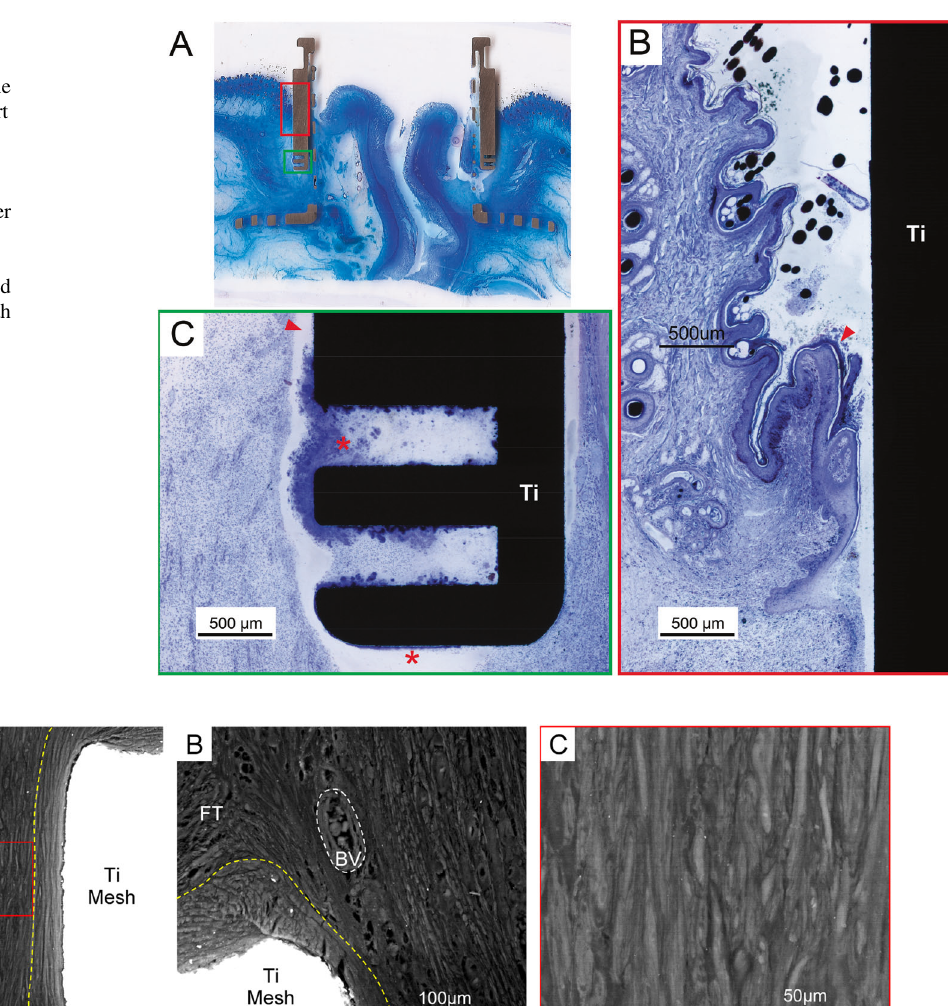
Fig. 6 Backscattered electron imaging (BSE-SEM) of the interface between the external part of the intestine and the inner surfaces of the titanium implant in urostomy model (EBM13, 14 weeks; shown in Fig. 4C). Images were obtained following sample treatment with iodine in potassium iodide (Lugol) solution. A The inner mesh (Ti Mesh) and the cylinder (Ti) showing integration with the fi brous tissue (FT) at the anti-mesenteric aspect of the intestine. Yellow-dotted line depicts part